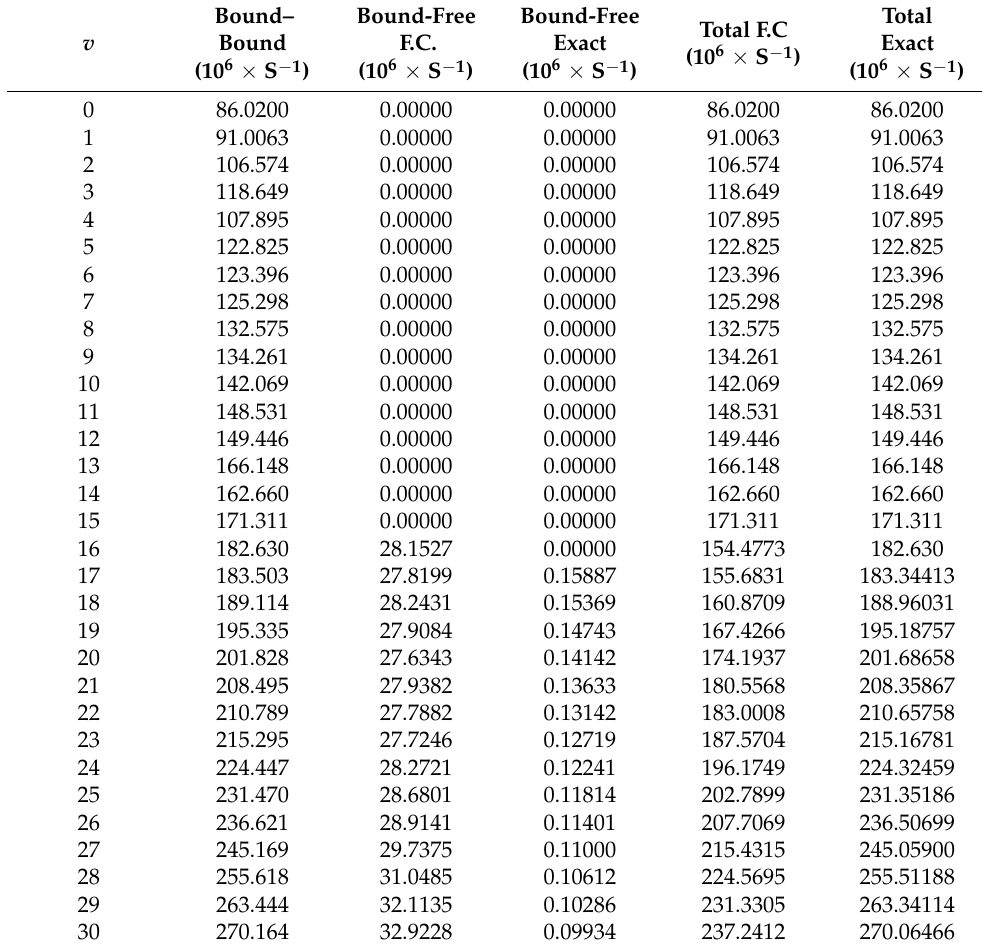
Table 2. Radiativelifetimes associated with the A → X emission of the ion (SrK) +